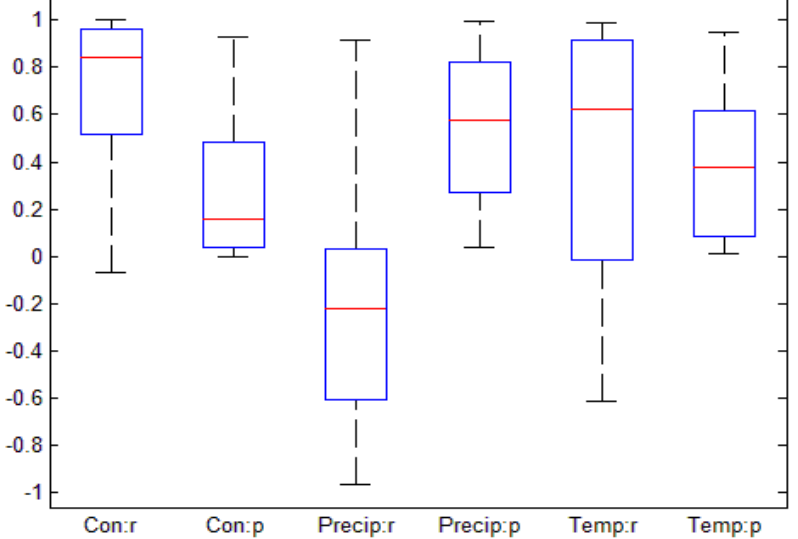
Figure 5. Partial correlation analysis results using vegetation conservation data acquired from regional statistical yearbook. “Con:r” and “Con:p” refer to the correlation coefficients and p values of the partial correlation between accumulated vegetation conservation and NDVI, with precipitation and temperature as control variables. “Precip:r” and “Precip:p” refer to the correlation coefficients and p values of the partial correlation between NDVI and precipitation, with conservation and temperature as control variables. “Temp:r” and “Temp:p” represent the correlation coefficients and p values of the partial correlation between NDVI and temperature, with annual precipitation and accumulated conservation as control